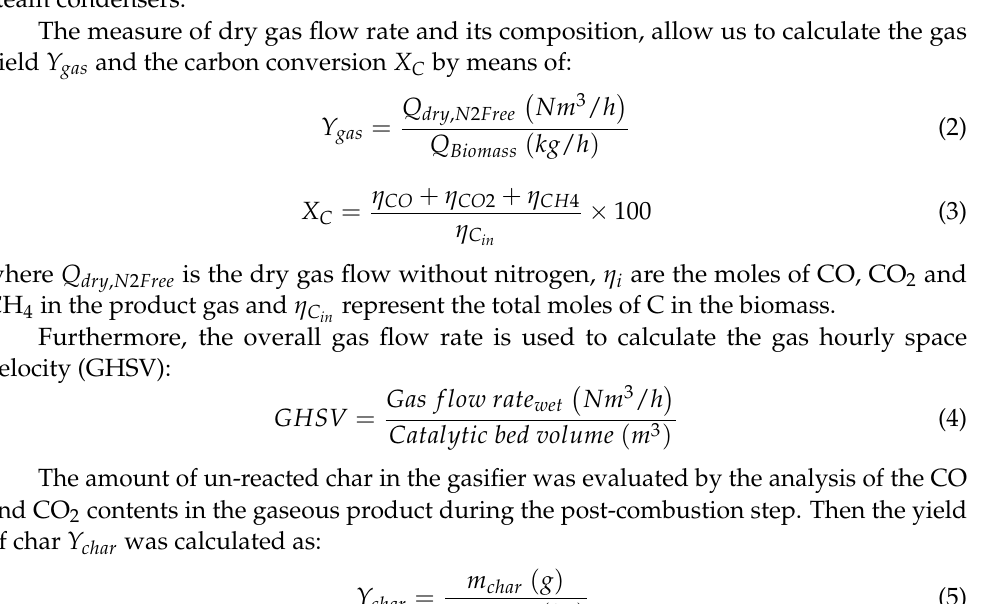
Table 5. Tar content in the product gas (mg/Nm 3 -N 2 free).